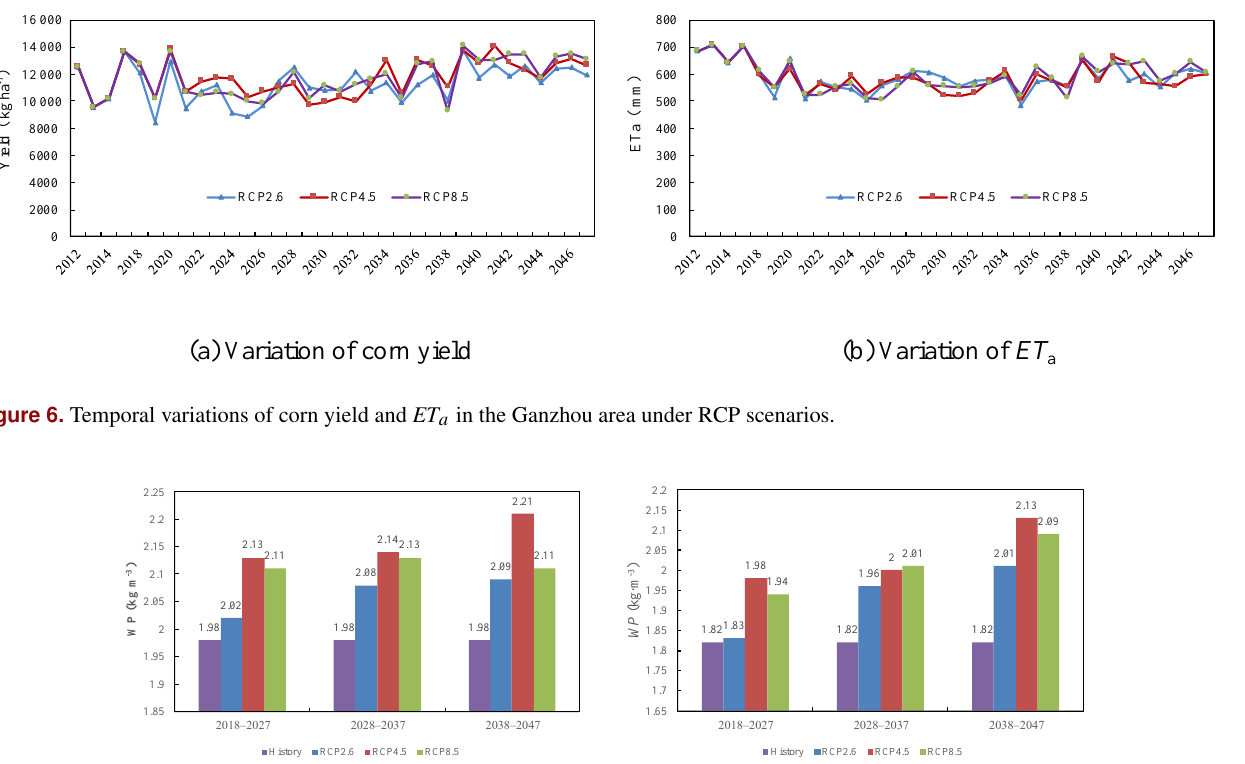
and the water productivity of the two locations